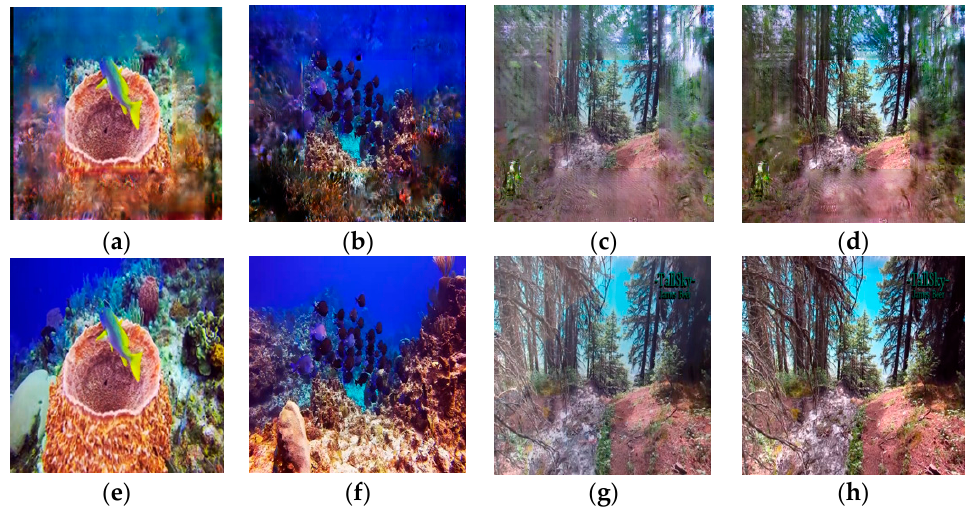
Figure 7. Testing of the PCE trained network for the Ocean and Forest datasets ( a – d ) First row shows the generated frames using trained PCE network, ( e – h ) Second row shows the ground truth frames for qualitative evaluation.